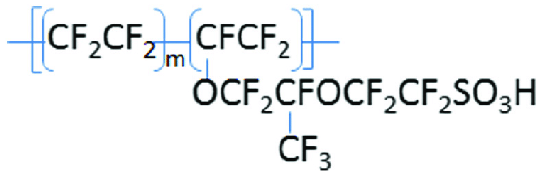
Figure 1. Chemical structure of Nafion [18].